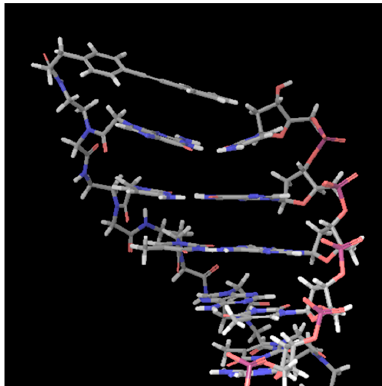
Figure 1. Conformational search of the tolane 1 modified Peptide nucleic acid (PNA)/DNA duplex. The original PNA/DNA duplex structure was obtained from the Protein Data Bank (PDB:1PDT). The conformational search was performed while using the force field OPLS2005 model in MacroModel.